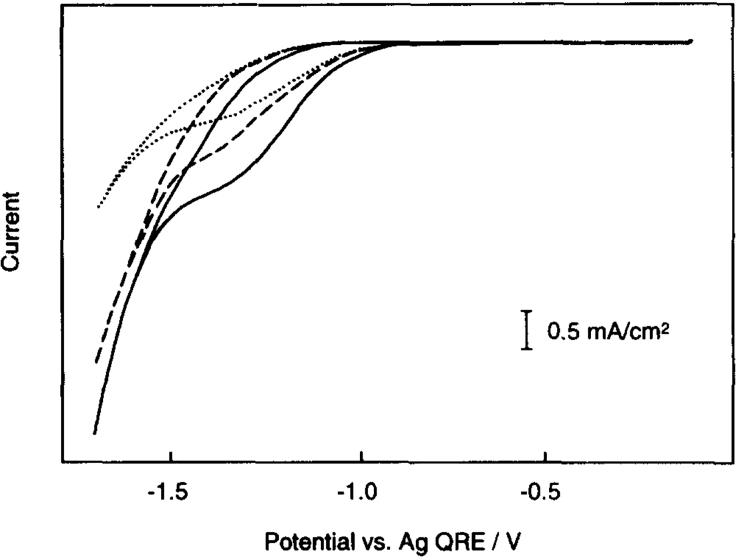
Cyclic Voltammetry Curve of the CO2 Reduction in MeOH with Various Concentrations of Bu4NBF4 (33 mM, dotted; 66 mM, dashed; 0.1 M, solid Line) as a Supporting Electrolyte at a Hg WE (versus Ag Quasi-RE)Reproduced with permission from (Saeki et al., 1995a, Saeki et al., 1995b).